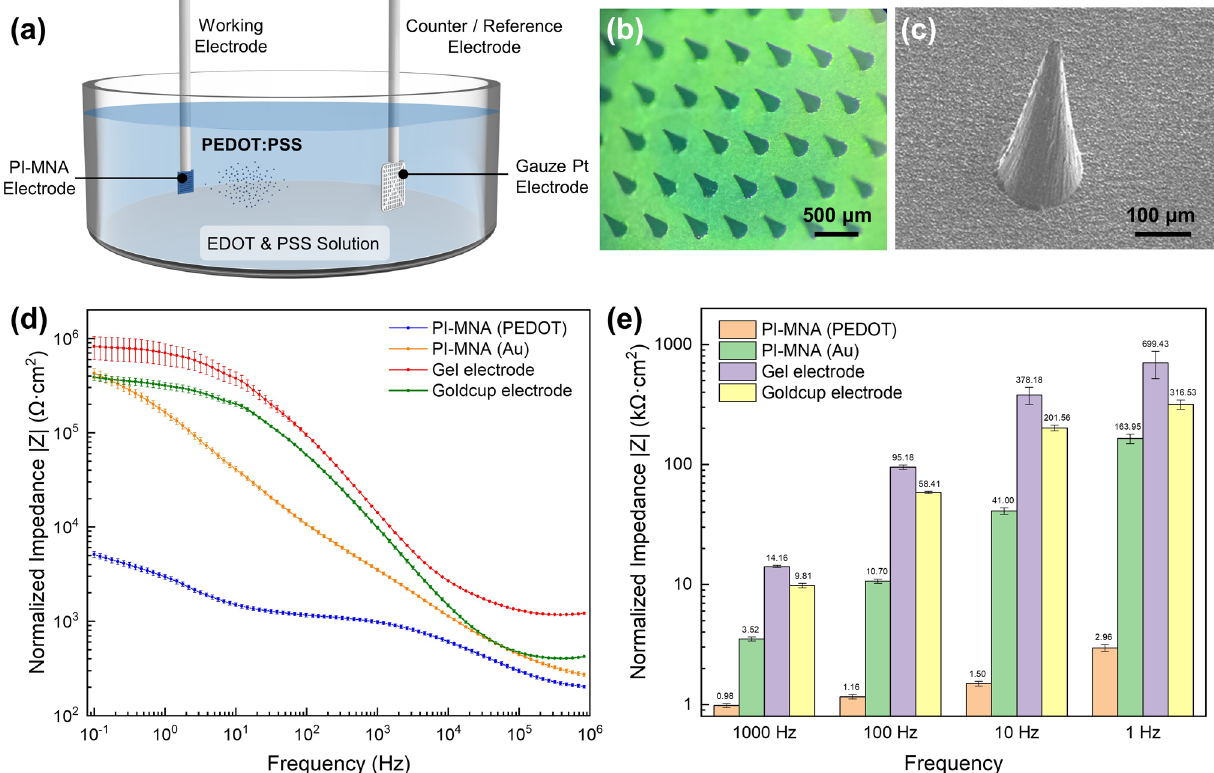
Fig. 4 a Schematic view of the electrochemical polymerization approach of PEDOT/PSS modification. b Optical and c SEM micrographs of the PI-MNA electrode after PEDOT/PSS modification. d EII spectra of different electrodes in the frequency range from 0.1 Hz to 1 MHz ( n = 20, mean ± standard error). e The specific EII modulus values ( n = 20, mean ± standard